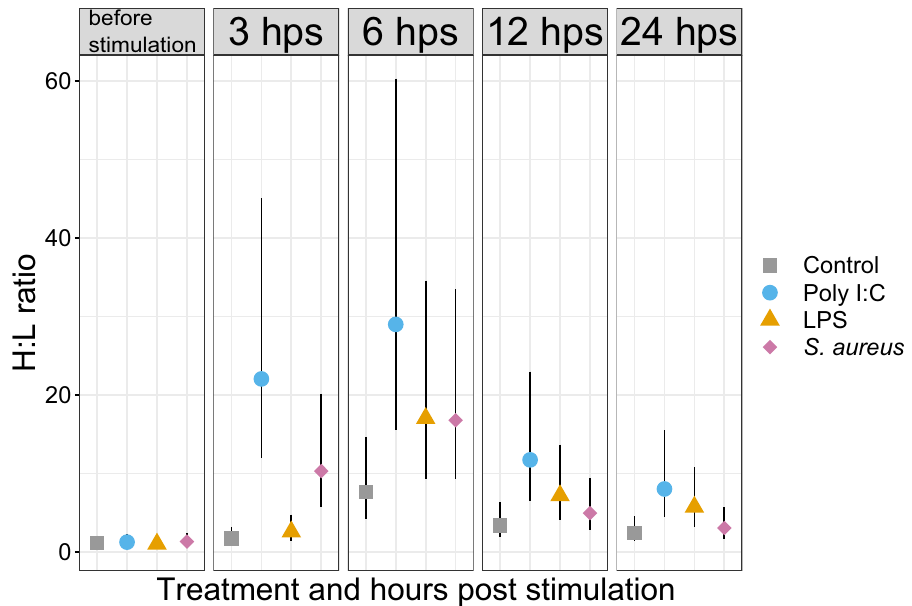
Figure 2. Elevated H:L ratios in mallard blood following challenge with immune stimulants. Mean H:L ratio and 95% credible intervals as estimated from the posterior distribution from the multinomial model (n = 5